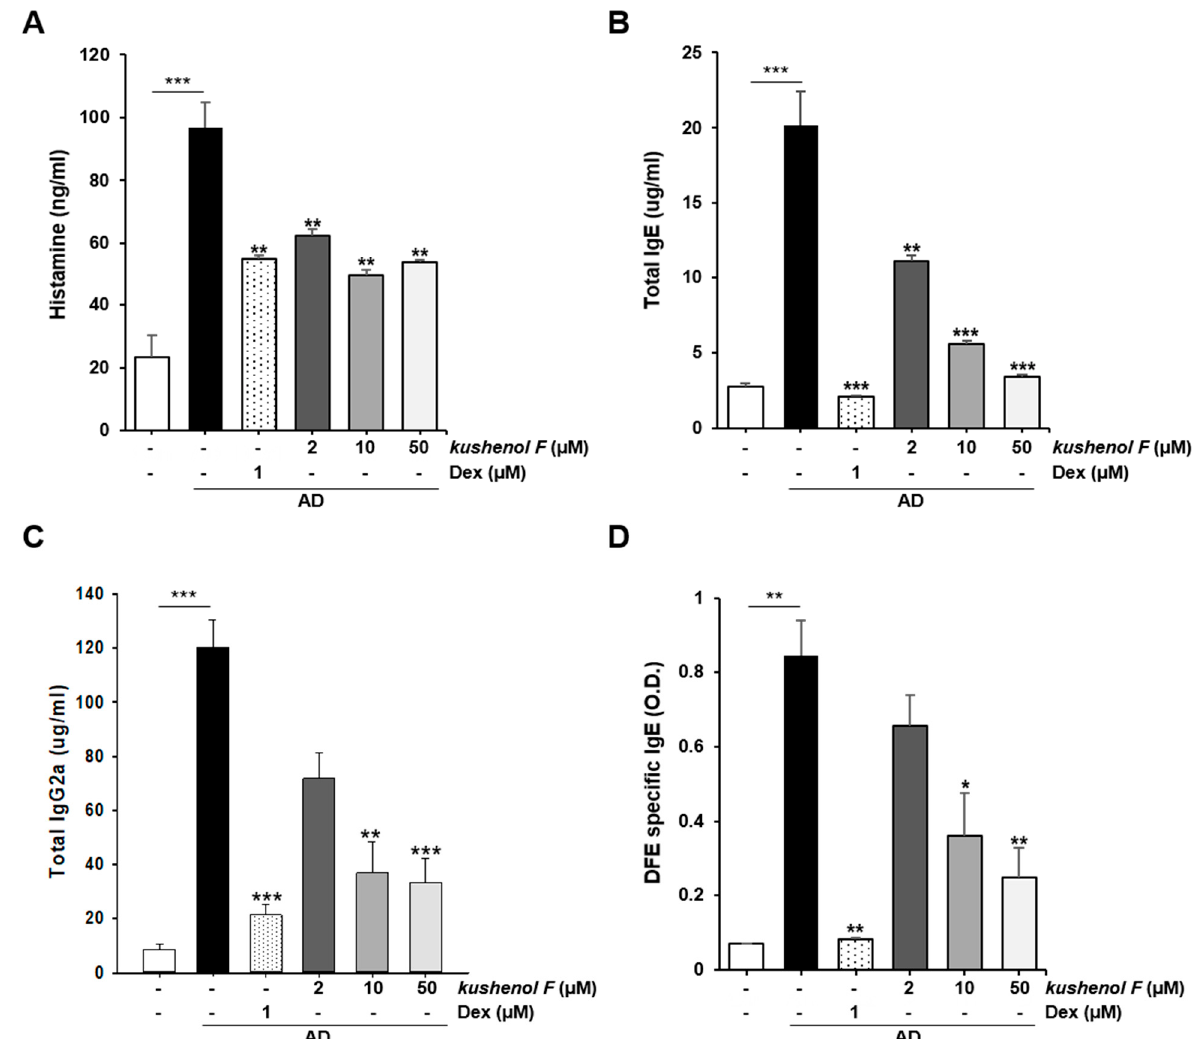
Figure 5. Effect of kushenol F on the serum histamine level and immunoglobulins. ( A ) Histamine levels were detected using a fluorescent plate reader. ( B ) Serum IgE, ( C ) serum IgG2a and ( D ) DFE- specific IgE concentrations were quantified using ELISA. The blood samples of the vehicle, DFE/DNCB + vehicle and DFE/DNCB + kushenol F (2, 10 or 50 mg/kg) groups were collected from the facial vein at 28 days. Data are presented as the mean ± SD ( n = 5). * p < 0.05, ** p < 0.01 and *** p < 0.001 vs. control. DFE, Dermatophagoides farinae extract; DNCB, 1-chloro-2,4-dinitrochlorobenzene.